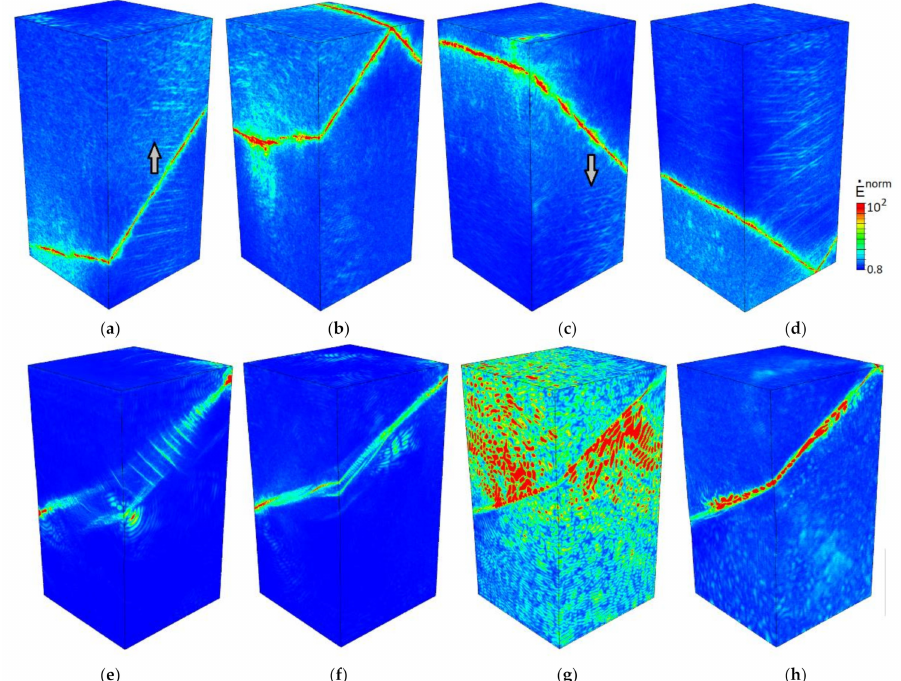
Figure 6. Normalized equivalent strain rates in a perfectly plastic single crystal with the {100} lateral faces compressed along the [001] axis for compressive strains of 0.008 ( a ), 0.009 ( b ), 0.01 ( c ), 0.011 ( d ), 0.038 ( e ), 0.039 ( f ), 0.04 ( g ), and 0.044 ( h ). Video S1 is available online in Supplementary Materials.